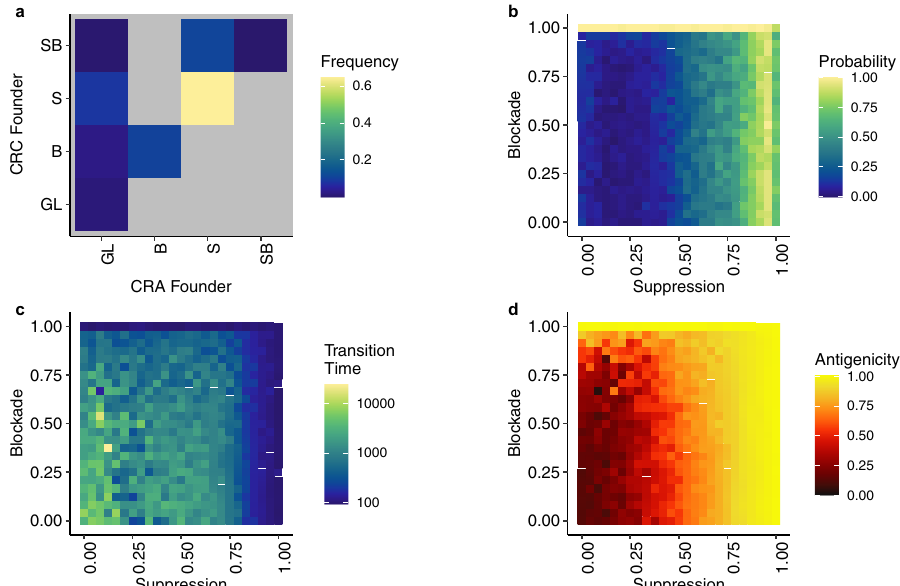
Fig. 3 Immune escape occurs early and increases the risk of tumor formation. a Comparison of the adenoma (CRA) founder ’ s immune escape phenotype to the eventual founding branch of the carcinoma (CRC) population, where GL = founder relied on Get Lucky, B = founder had Blockade, S = founder had Suppression, and SB = founder had Suppression and Blockade. Out of the 21,723 simulations, 75.87% of the simulations had the acquisition of Suppression as an early event, occurring in the CRA founder and later inherited by the CRC founder. b The probability of a carcinoma forming under various strengths of immune escape. Probability is calculated as the number of times a carcinoma existed for 1 year, divided by the number of times that parameter set was run, in this case, 100 times each. The gradient from left to right indicates that immune suppression increases the probability of tumor formation, while lack of a gradient from top to bottom suggests that immune blockade has little effect on the probability. c The average amount of time, in days, between CRA and CRC formation, i.e., the transition time, for each parameter set. Tumors that progressed most rapidly from CRA to CRC are those with an immunosuppressive strategy, which reduces immune predation and relaxes selection against high antigenicity. d Averages of each malignant tumor ’ s mean antigenicity (weighted by each population ’ s size) for each parameter combination. The horizontal gradient indicates that immune suppression allows for increased antigenicity, as immune suppression relaxes selection against